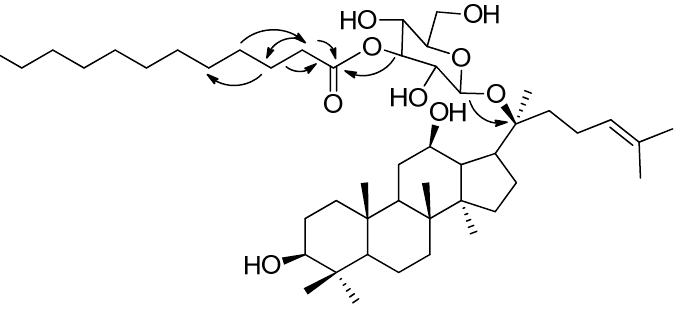
Figure 6. Selected key HMBC correlations of 2A (H → C).